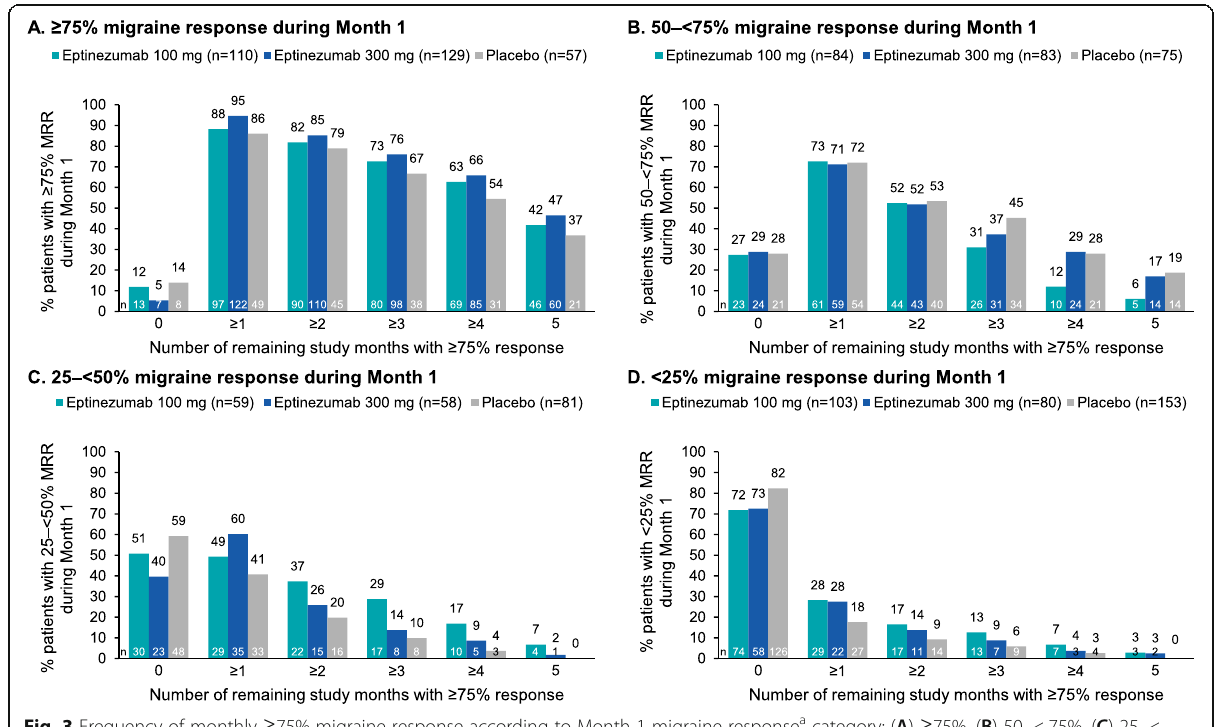
Fig. 3 Frequency of monthly ≥ 75% migraine response according to Month 1 migraine response a category: ( A ) ≥ 75%, ( B ) 50 – < 75%, ( C ) 25 – < 50%, ( D ) < 25% . a Migraine response was defined as a reduction in monthly migraine days. MRR, migraine responder